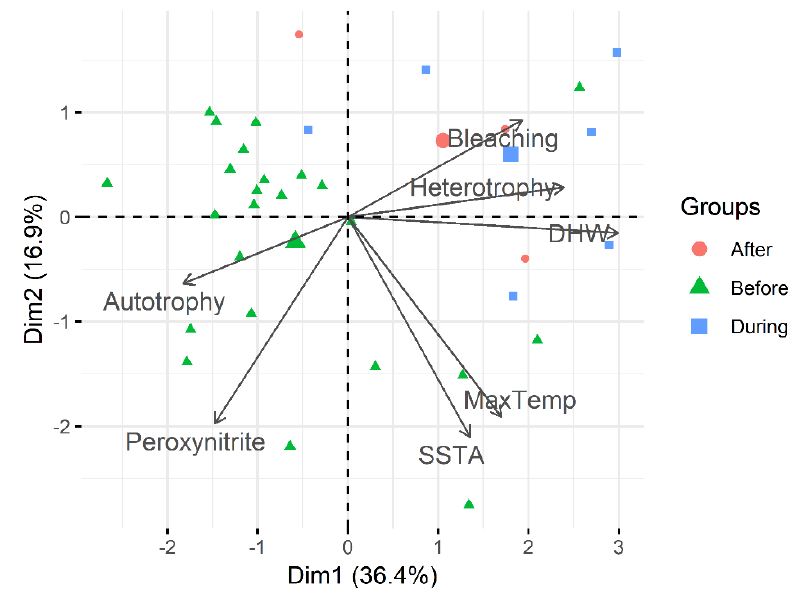
Figure 5. Principal component analysis of bleaching, degree heating weeks (DHW), sea surface temperature anomaly (SSTA), maximum temperature (MaxTemp), autotrophy, heterotrophy, and peroxynitrite in Millepora alcicornis ( A ) and Mussismilia harttii ( B ). All traits were grouped into 3 clusters: after, before, and during the bleaching event. The two main eigenvectors retained, respectively, 60.6% (Dim1 = 35.9%; Dim2 = 24.7%) and 53.3% (Dim1 = 36.4%; Dim2 = 16.9%) of the total variance.